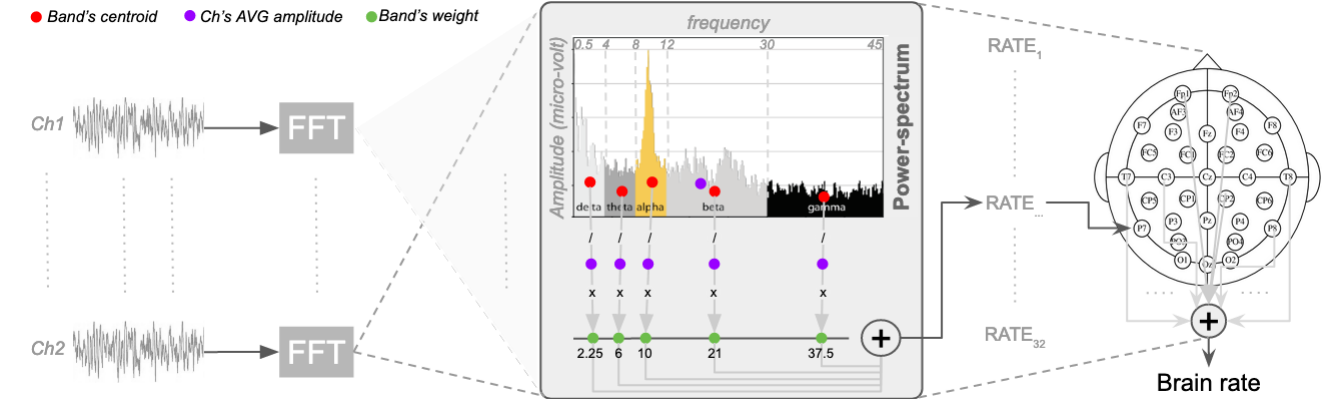
Figure 1. Diagrammatic illustration of the computation of the mean frequency of brain oscillations, via fast-Fourier Transformation (FFT), weighted over the EEG bands of potential (power) spectrum for each channel and their final aggregation towards a brain